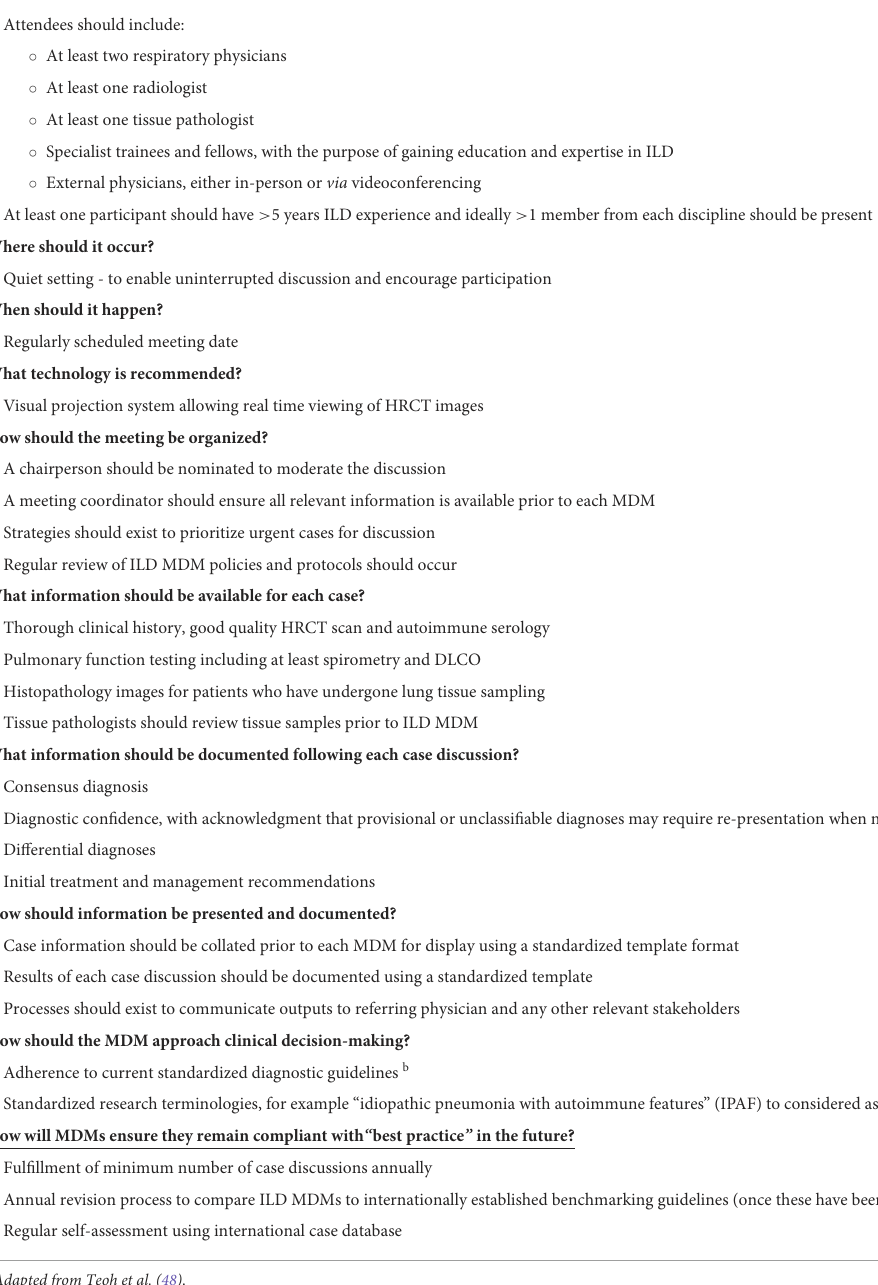
TABLE 2 Essential and desirable features of the ideal ILD MDM based on expert consensus a